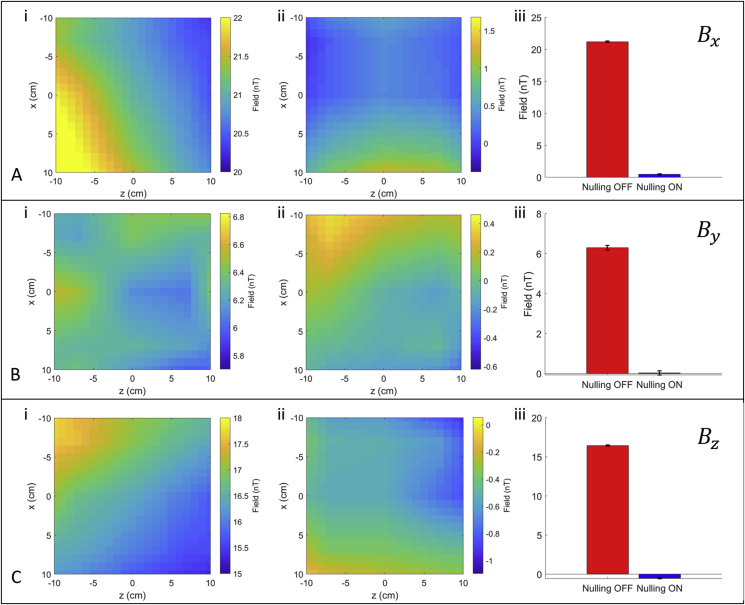
A) B) and C) show for Bx, By and Bz respectively i) a map of the field before nulling is applied ii) a map of the field after nulling is applied and iii) the average field magnitude with error-bars showing the standard deviation of measurement before (red) and after (blue) nulling is applied.